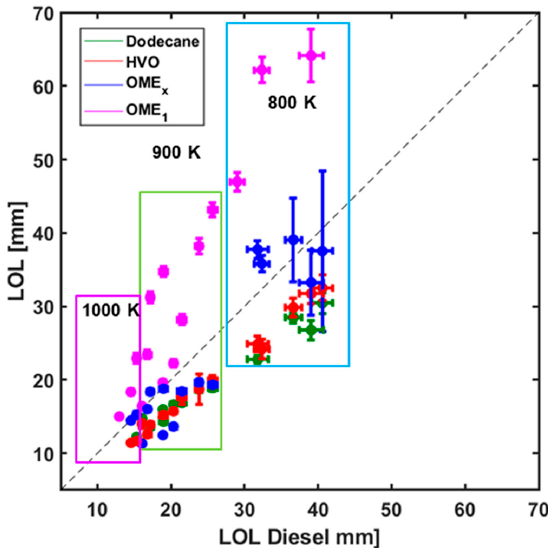
Figure 7. Comparison between lift-off length (LOL) of diesel and the other fuels